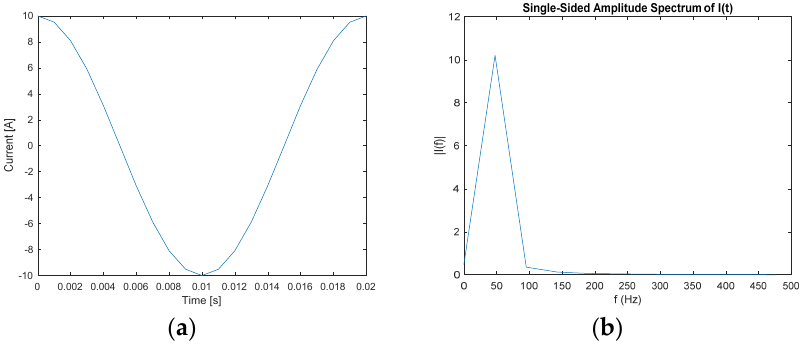
Figure 3. An example of sinusoidal signal in ( a ) time domain and ( b ) frequency domain.